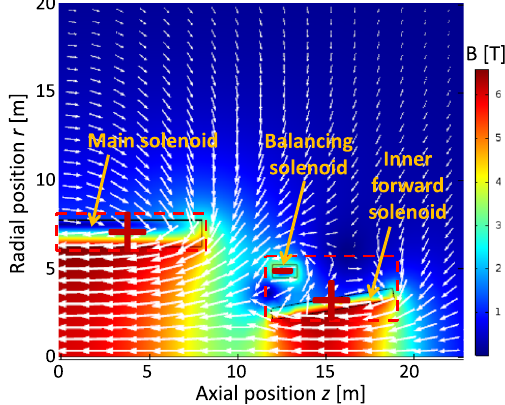
FIG. 12. Two-dimensional axisymmetric representation of half of the unshielded solenoid in combination with a balanced forward solenoid. Here the arrows and colors indicate the magnetic field orientation and magnitude, respectively. The plus and minus signs indicate the direction of the current inside the superconducting coils.